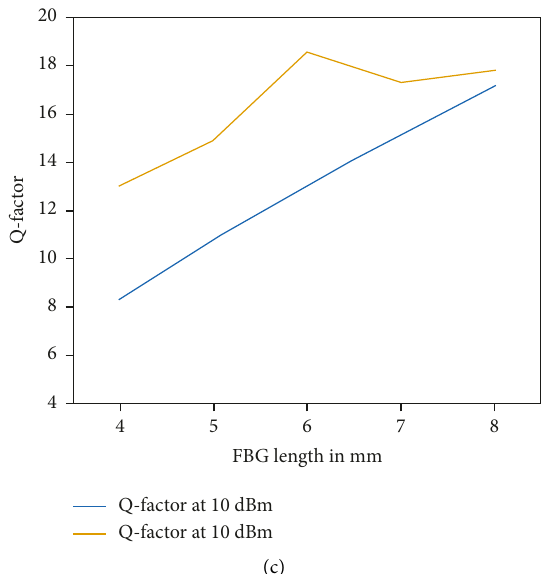
Figure 5: Comparison of linear Gaussian versus linear tanh profile 3 FBG+DCF. (a) for 5dBm, (b) for 7.5dBm, and (c) for 10dBm.